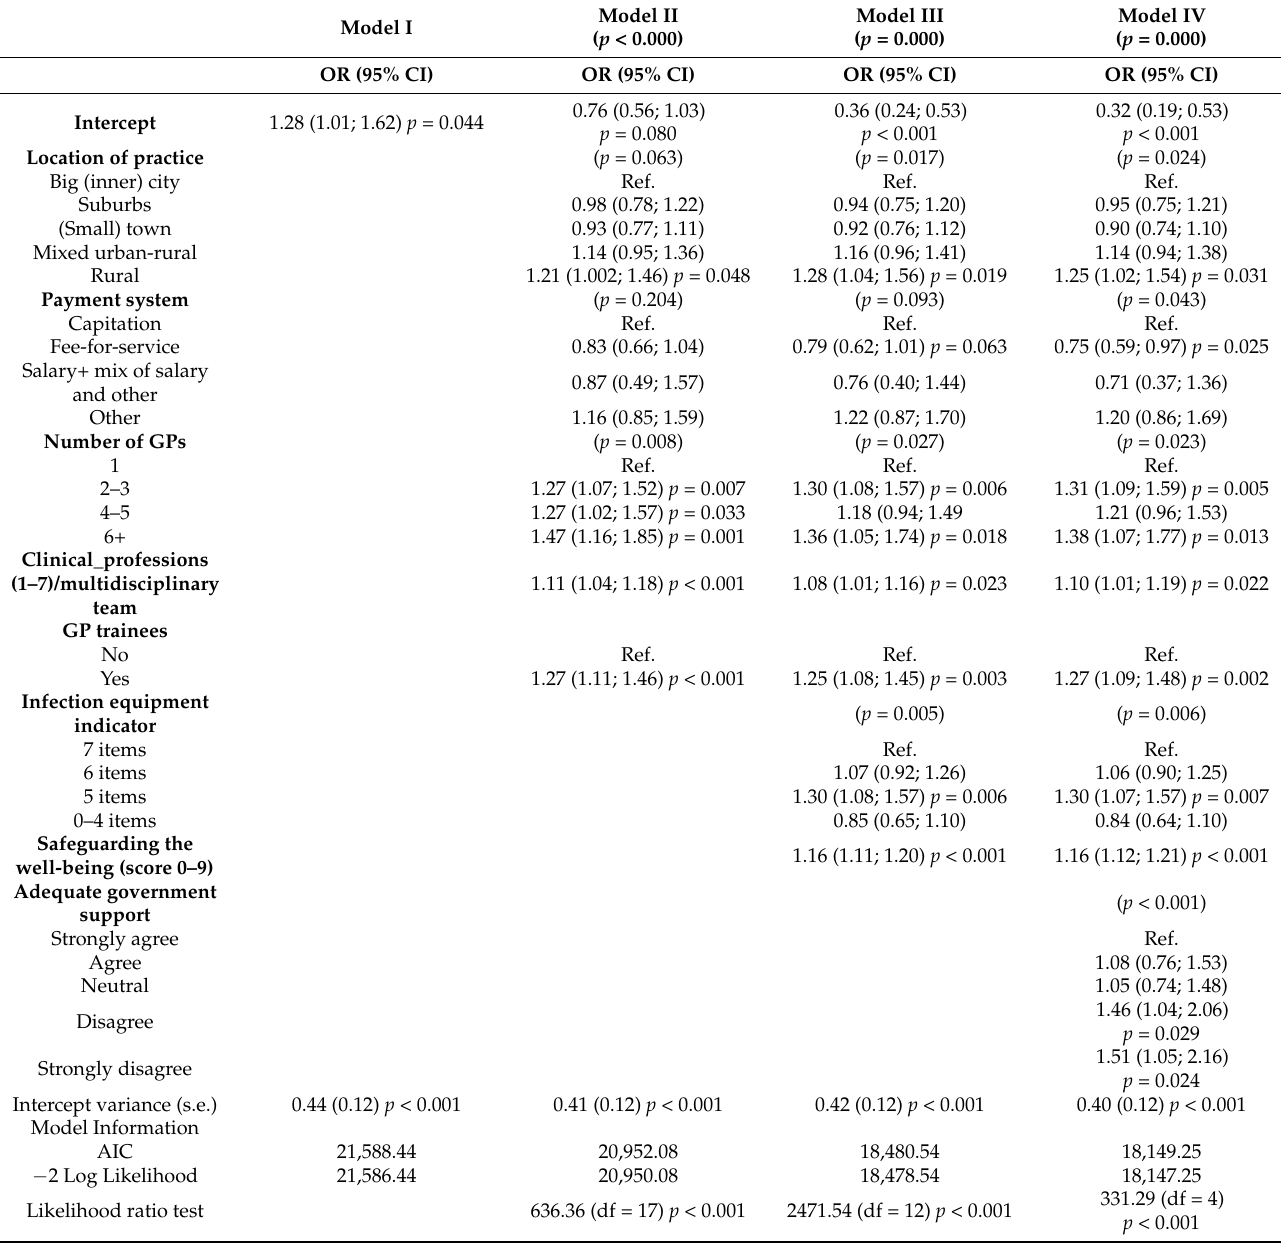
Table 5. Results of mixed effects logistic regression analysis of potential predictors for considering making adjustments to the building or the